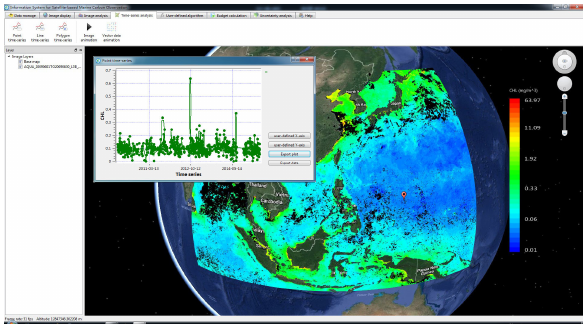
Figure 5. Time-series point statistics of the daily CHL products from 2010 to 2015